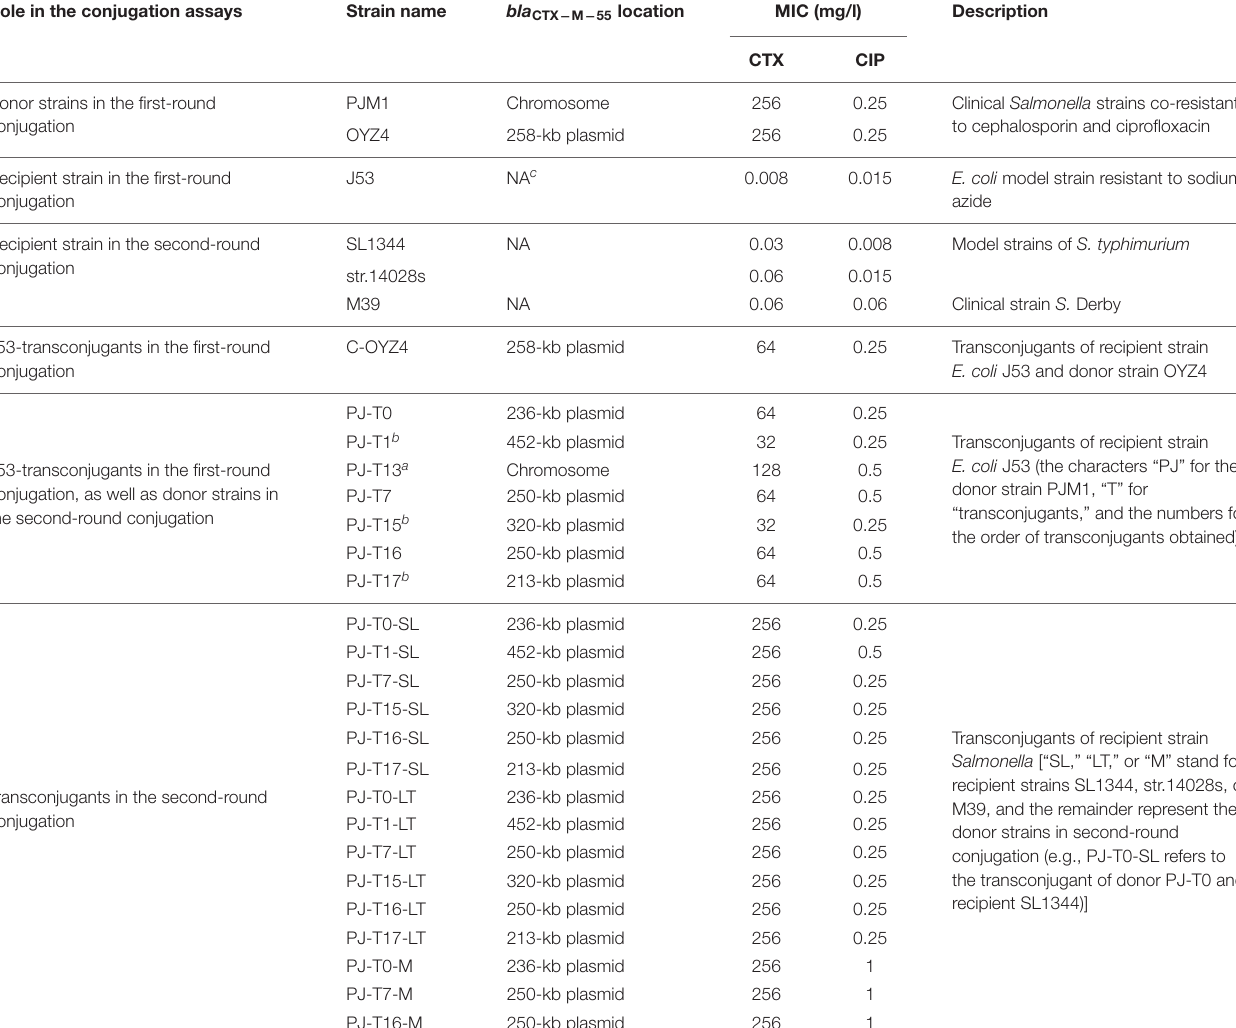
TABLE 1 | Characteristics of bla CTX − M − 55 -bearing positive strains and their corresponding